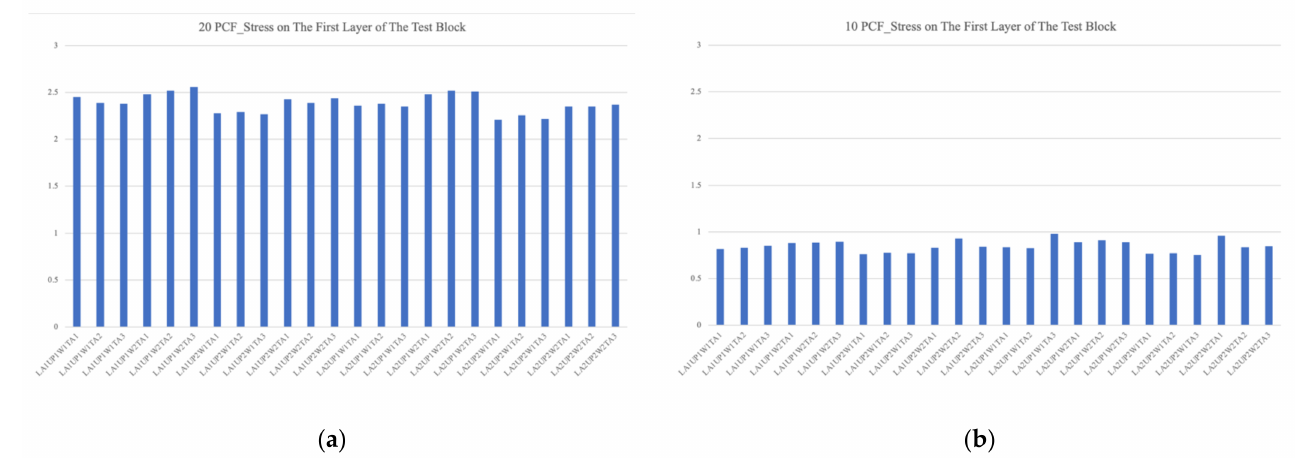
Figure 10. Comparison of the stress on the first layer of test block of 24 groups in ( a ) 20 PCF and ( b ) 10 PCF.